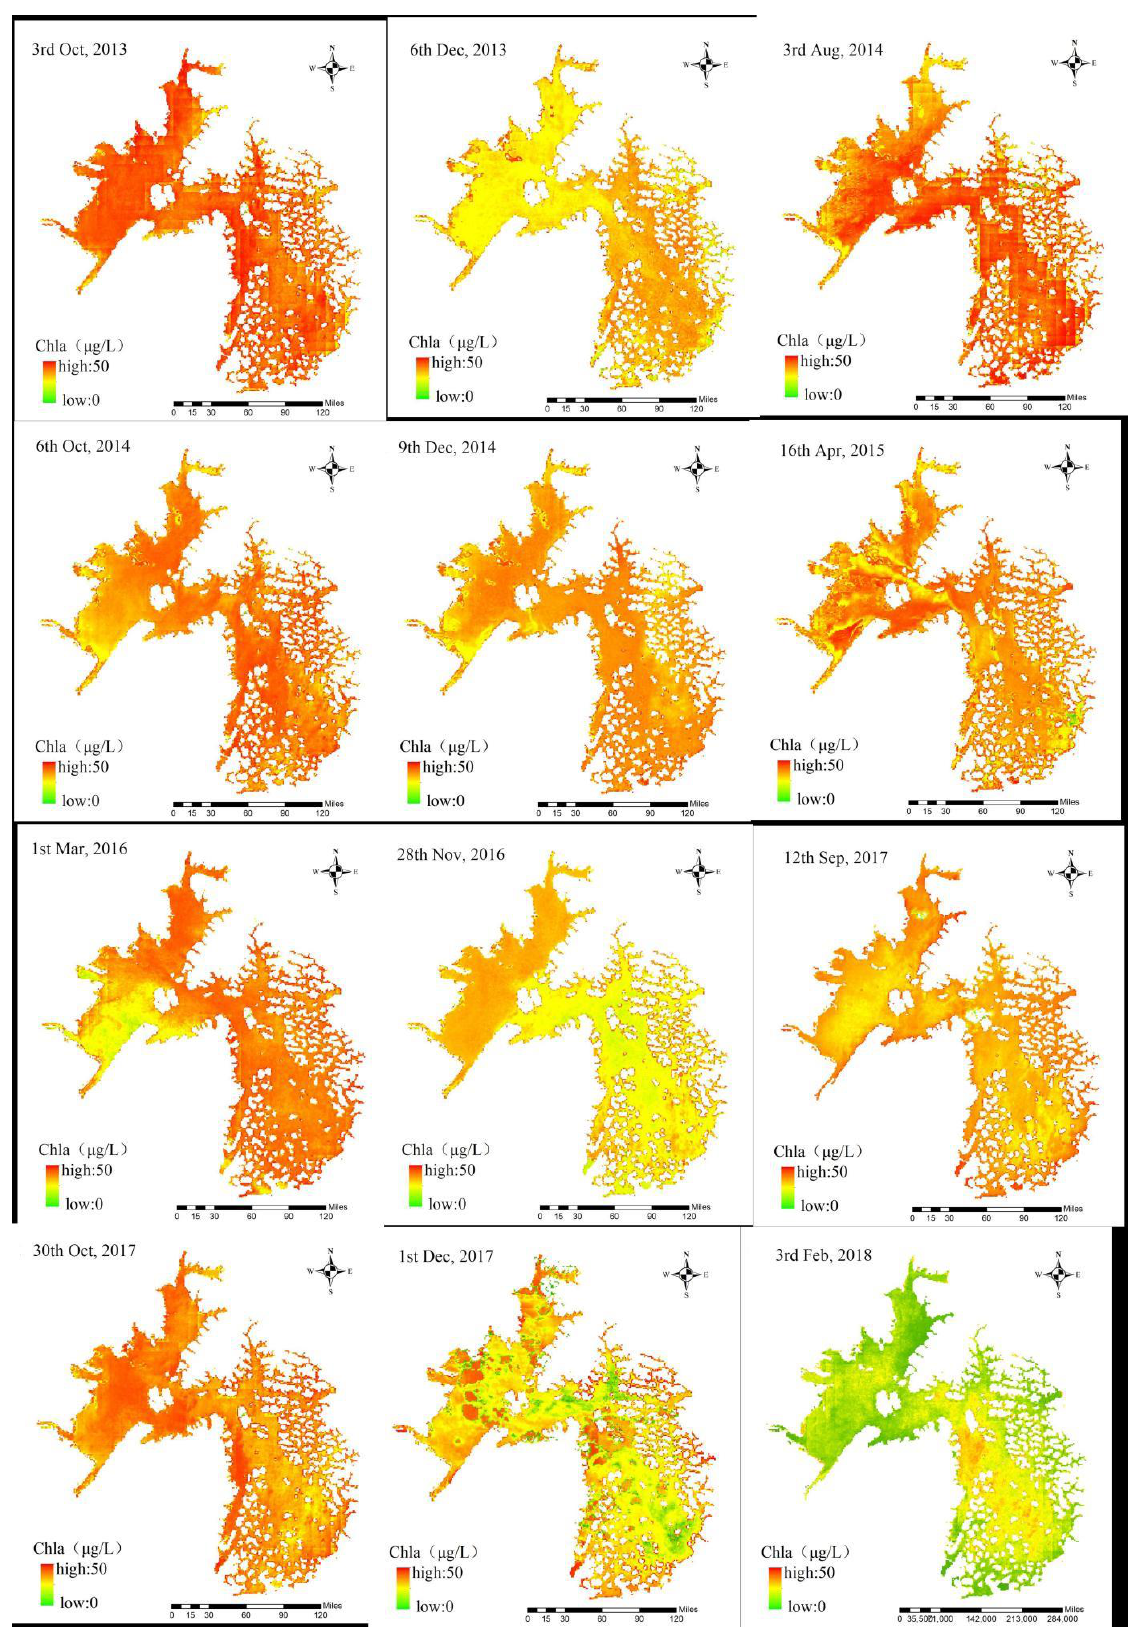
Figure 5. Distribution of the concentration of Chl-a across the Dashahe Reservoir.